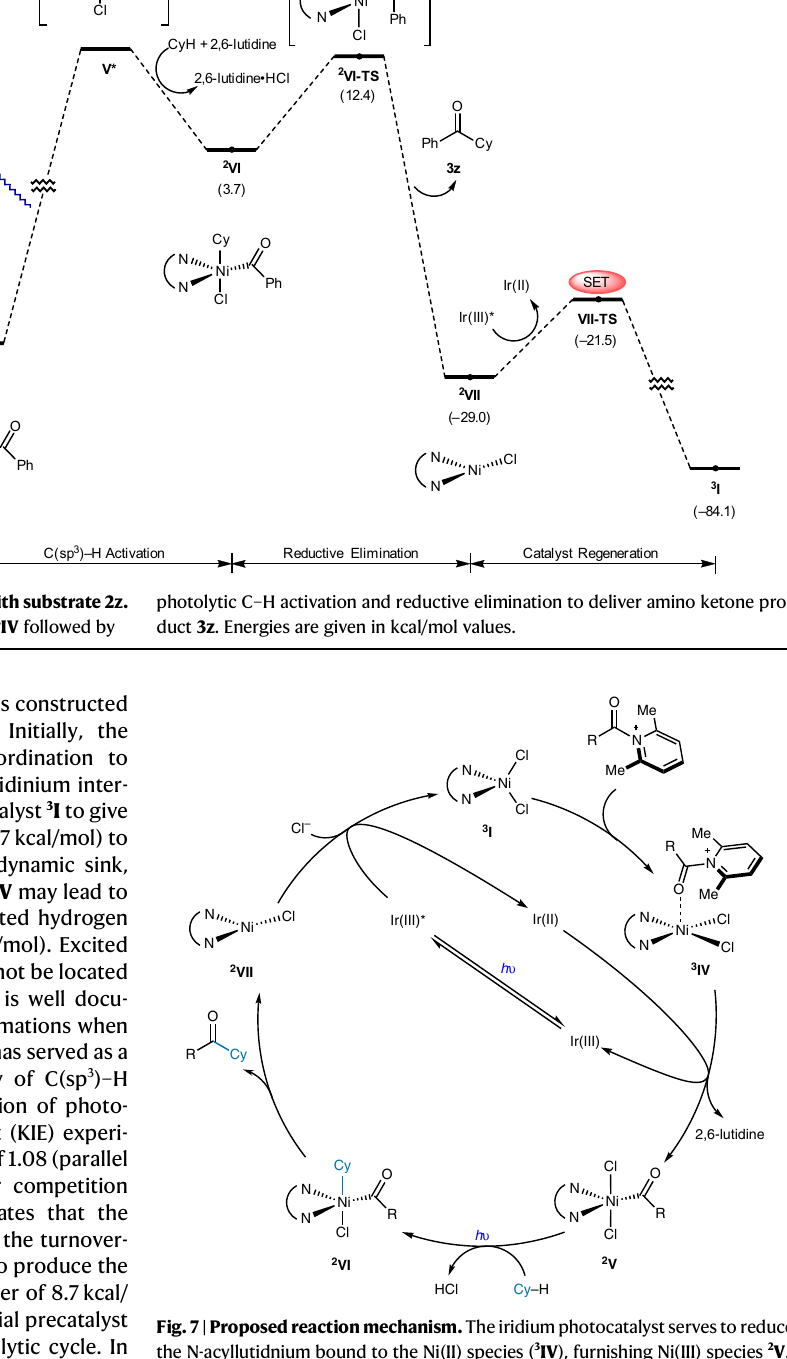
Fig.7|Proposedreactionmechanism. Theiridiumphotocatalystservestoreduce the N-acyllutidnium bound to the Ni(II) species ( 3 IV ), furnishing Ni(III) species 2 V . 2 V undergoeslight-assistedC – Hactivationandreductioneliminationtodeliverthe ketone product and Ni(I) species 2 VII . Finally, 2 VII is oxidized back the the initial catalyst 3 I